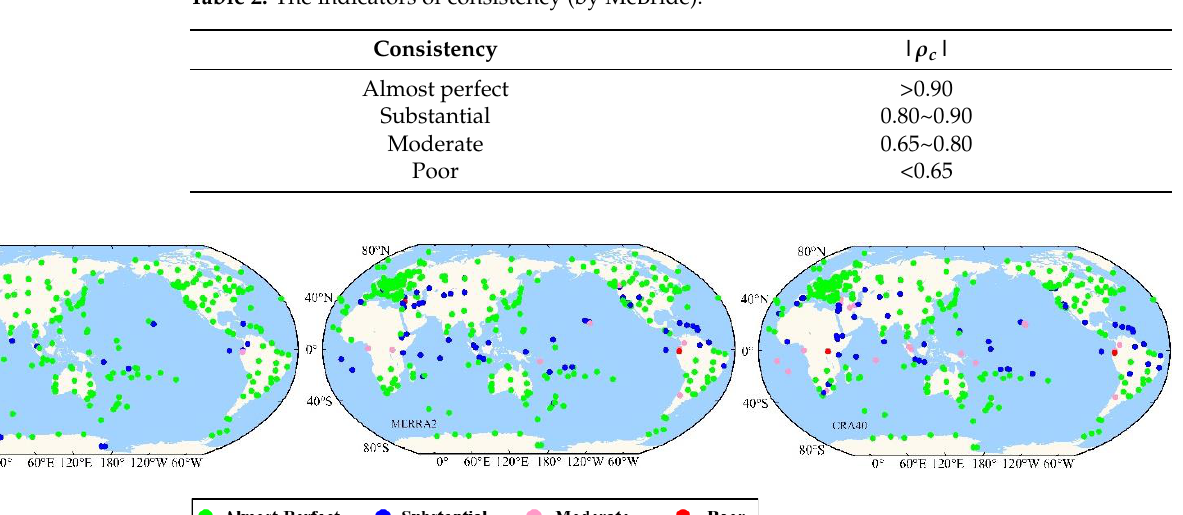
Table 2. The indicators of consistency (by McBride).